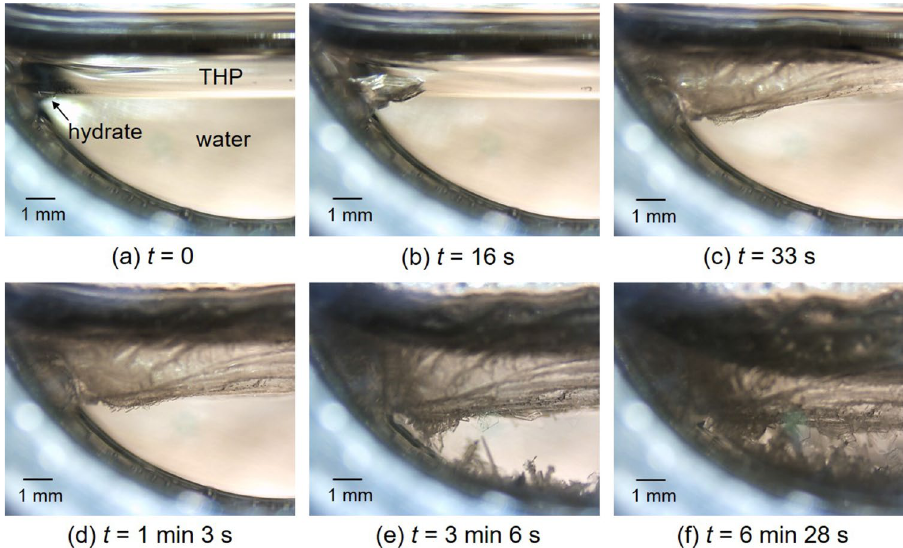
Figure 4. Sequential images of H 2 + CO 2 + THP hydrate growing in the liquid bulk at T ex = 282.0 K, Δ T sub = 5.1 K, P = 5.30 MPa. The gas composition was H 2 :CO 2 = 0.55:0.45 in mole fraction. The elapsed time after the hydrate nucleation is indicated below each image.